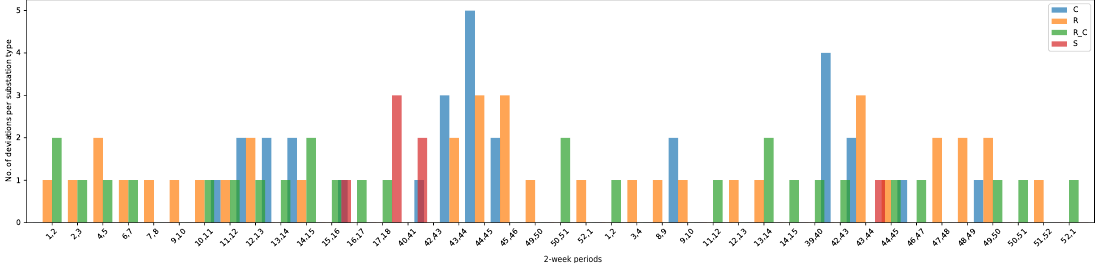
Figure 4. Number of substations with bi-weekly deviating behaviours on a daily basis and their categories during the heating season in 2017 and